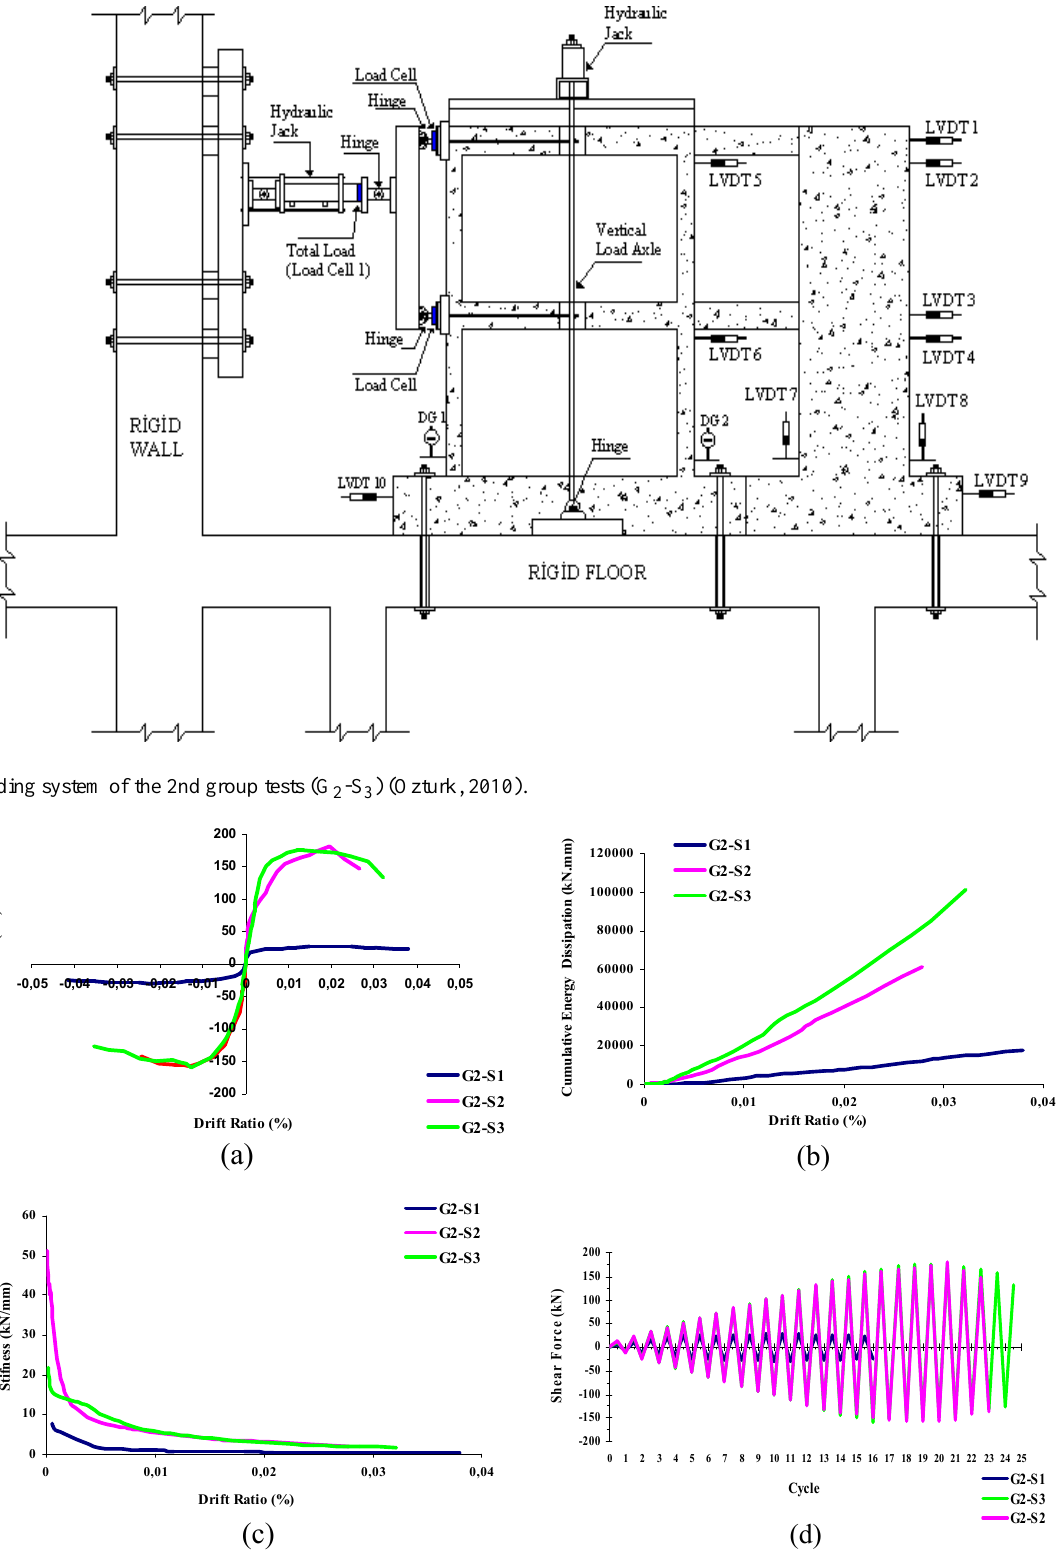
Fig. 8. Results of the 2nd group tests - (a) load-displacement envelope curve of specimens, (b) energy dissipation capacity graphs of specimens, (c) stiffness characteristics of specimens, (d) load histories of Figure 8. Results of the 2 nd group tests – (a) Load–displacement envelope curve of specimens Figure 8. Results of the 2 nd group tests – (a) Load–displacement envelope curve of specimens (b) Energy dissipation capacity graphs of specimens (c) Stiffness characteristics of specimens (b) Energy dissipation capacity graphs of specimens (c) Stiffness characteristics of specimens Figure 8. Results of the 2 nd group tests – (a) Load–displacement envelope curve of specimens Figure 8. Results of the 2 nd group tests – (a) Load–displacement envelope curve of specimens (d) Load histories of specimens (d) Load histories of specimens (b) Energy dissipation capacity graphs of specimens (c) Stiffness characteristics of specimens (b) Energy dissipation capacity graphs of specimens (c) Stiffness characteristics of specimens (d) Load histories of specimens (d) Load histories of specimens